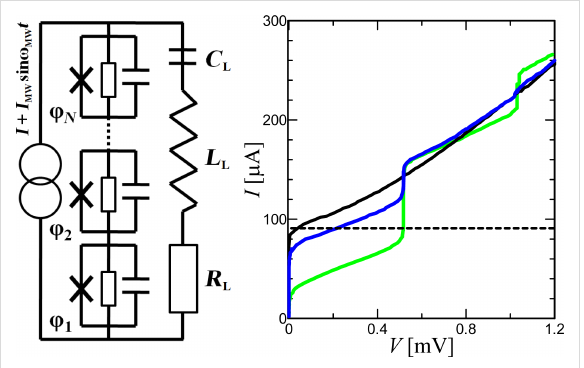
Figure 5: Left: circuit schematic of JJs in a series array interacting via a common RLC load. Right: current–voltage characteristics of a single junction in the absence and under the influence of an external 250 GHz signal, from bottom to top: P MW = 250, 50, and 0 nW. The dotted line is the optimal bias